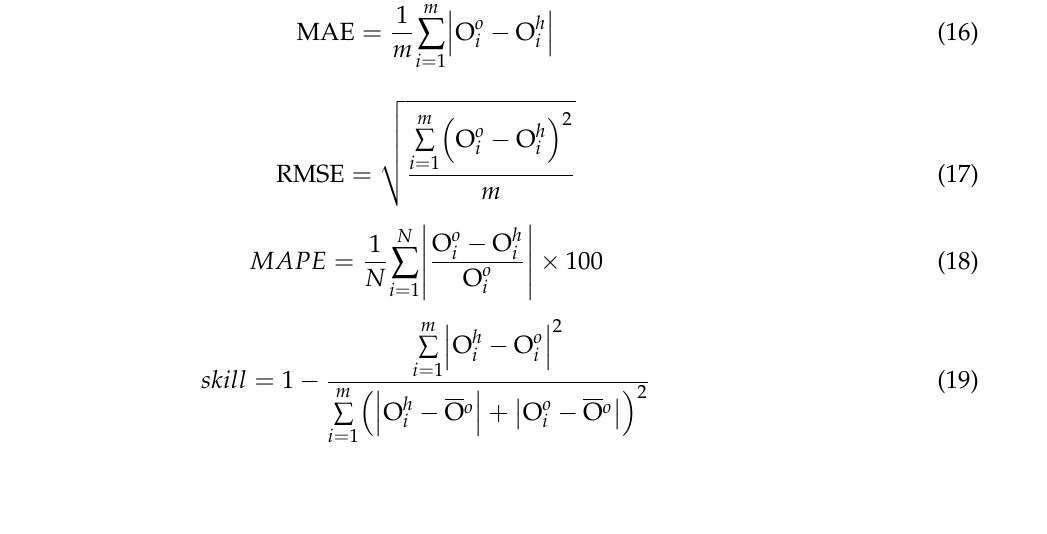
Figure 5. Nine categories of typhoon tracks classified by the Central Weather Bureau of Taiwan.